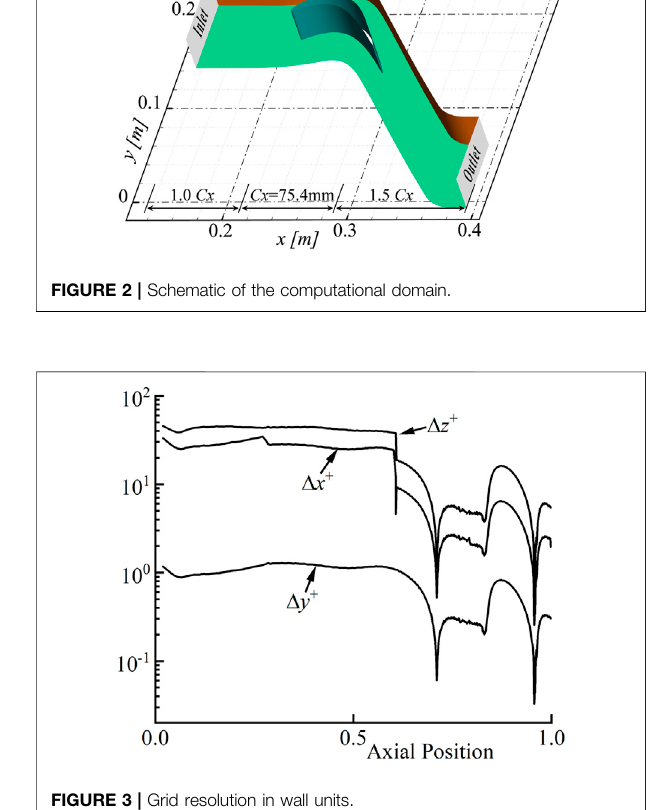
FIGURE 3 | Grid resolution in wall